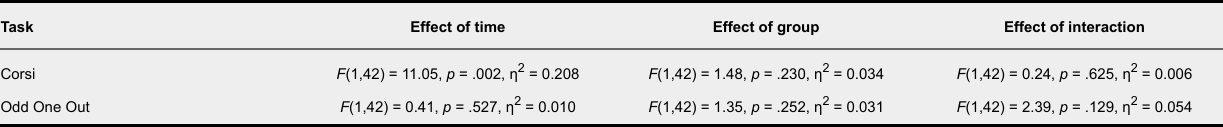
Task Effect of time Effect of group Effect of interaction Corsi F (1,42) = 11.05, p = .002, η 2 = 0.208